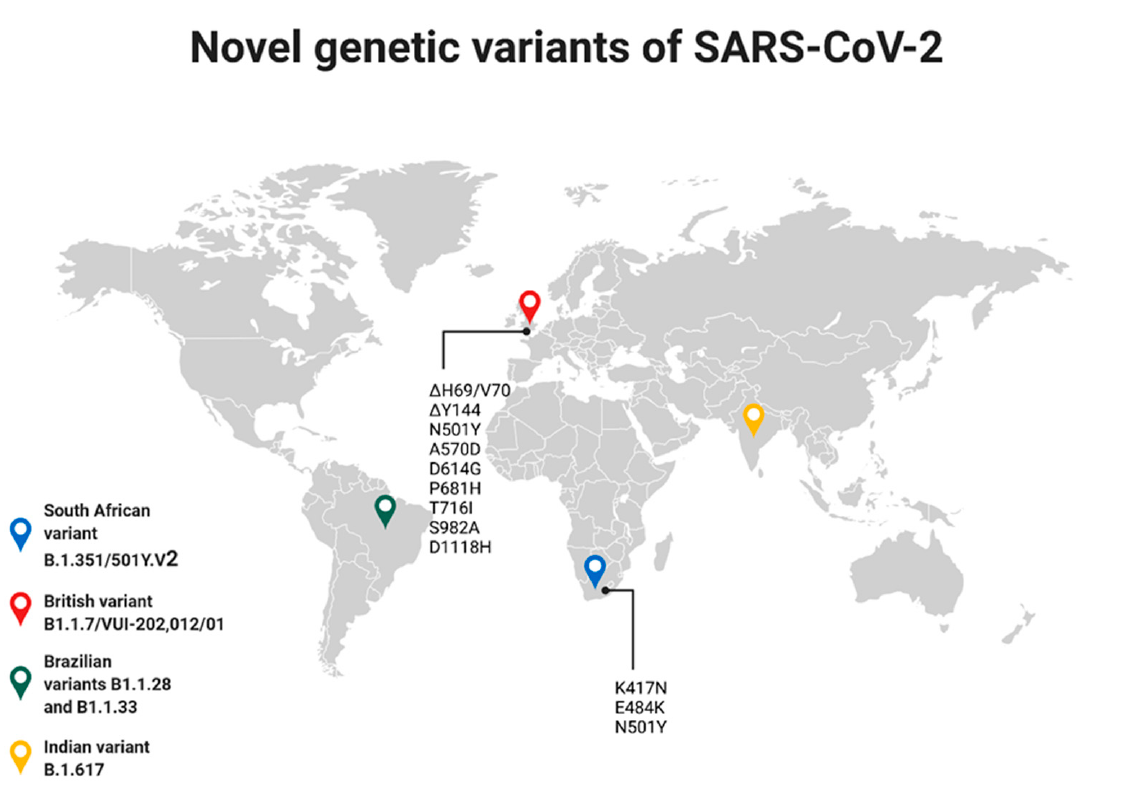
Figure 3. Novel genetic variants of SARS-CoV-2 have been described and their origin is marked on the map. Additionally, mutations responsible for the occurrence of British and South African variants are marked. Created with BioRender.com (accessed on 8 May 2021).